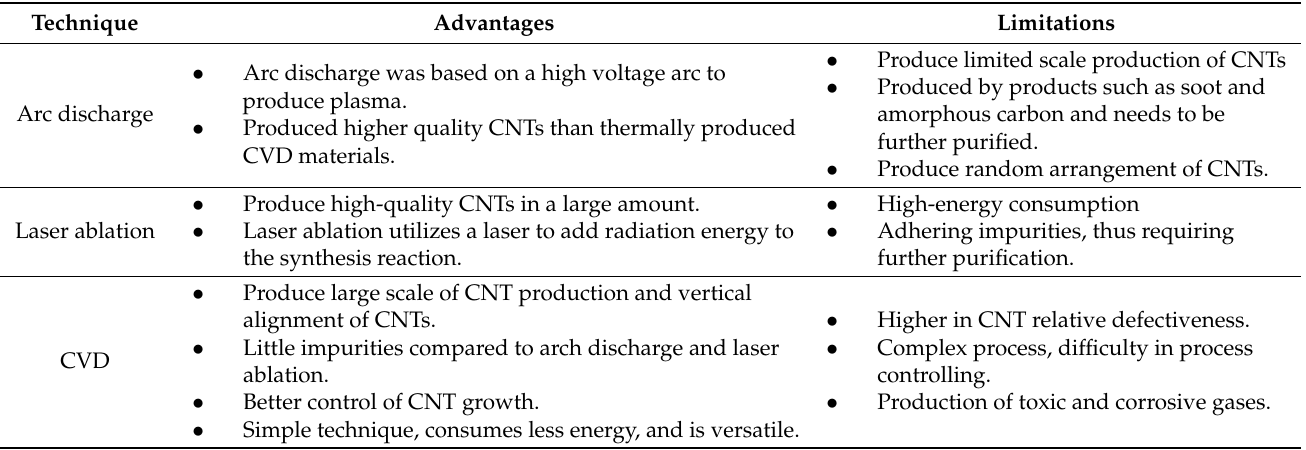
Table 1. The advantages and limitations on some of the techniques used in the preparation of carbon nanotubes (CNTs). CVD: chemical vapor deposition. Technique Advantages